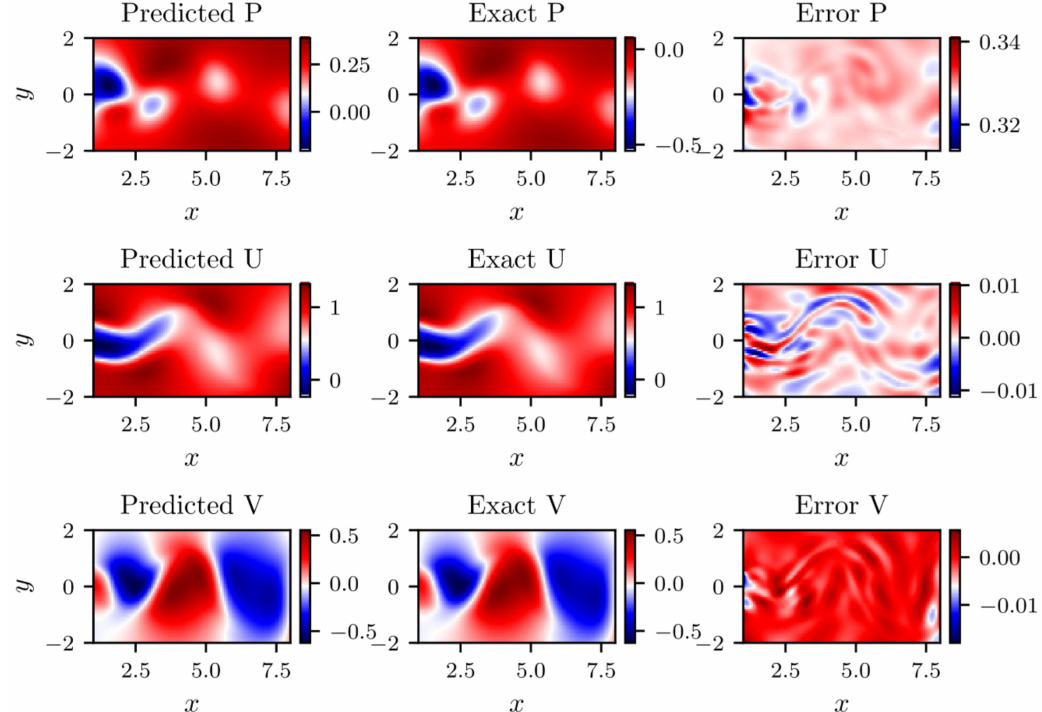
Figure 14. 2D predicted versus exact flow information at test time (with noise